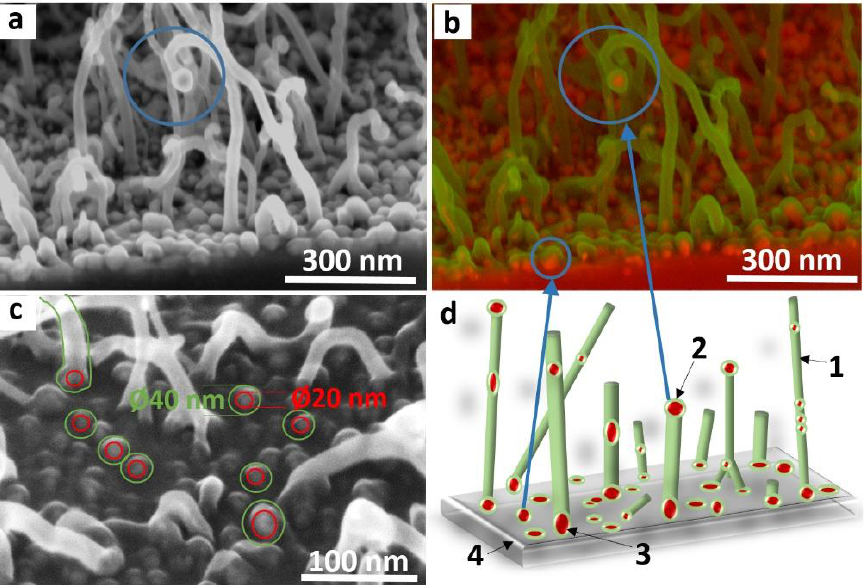
Figure 5. SEM images of catalytic layer and MWCNT array on silicon substrate obtained in the secondary electron registration mode at an accelerating voltage of 2 kV ( a ), in secondary (green color) and backscattering (red color) electron registration modes ( b ), and in secondary electron mode at 5 kV ( c ). Scheme of the initial growth stage of MWCNT array on silicon substrate ( d ). The numbers indicate: 1 — MWCNT, 2 — catalytic nanoparticle for tip growth; 3 — catalytic nanoparticle for root growth; 4 — silicon substrate.